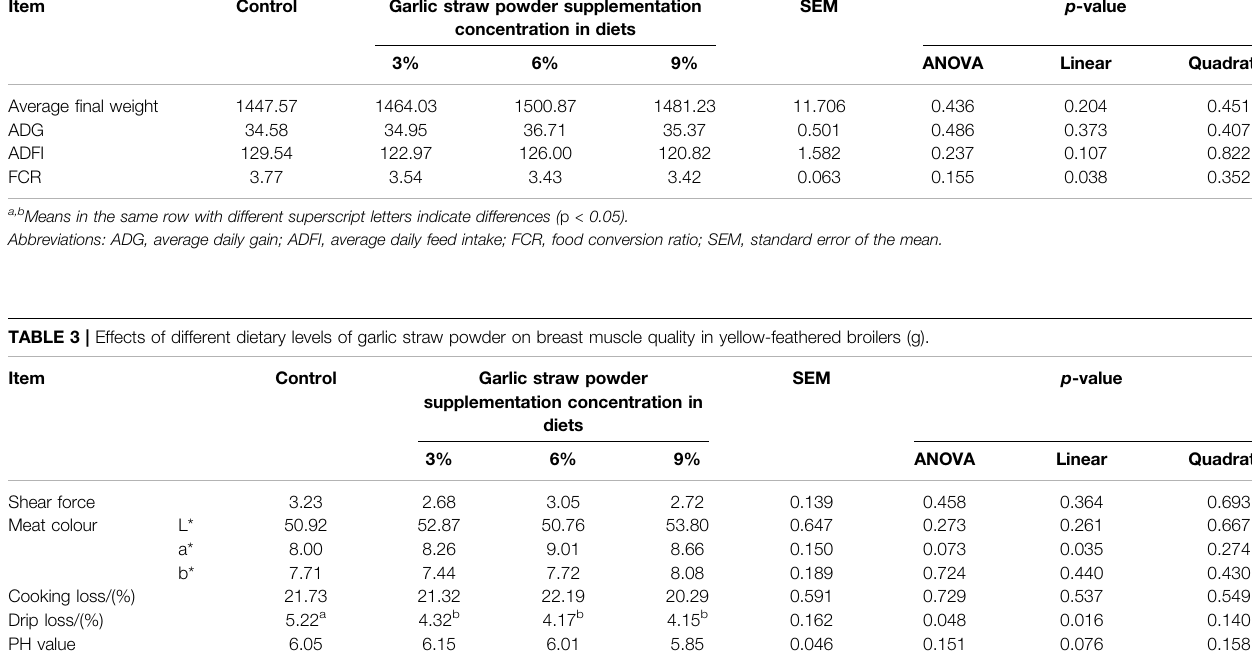
TABLE 2 | Effects of different dietary levels of garlic straw powder on growth performance in yellow feather broiler (g). Item Control